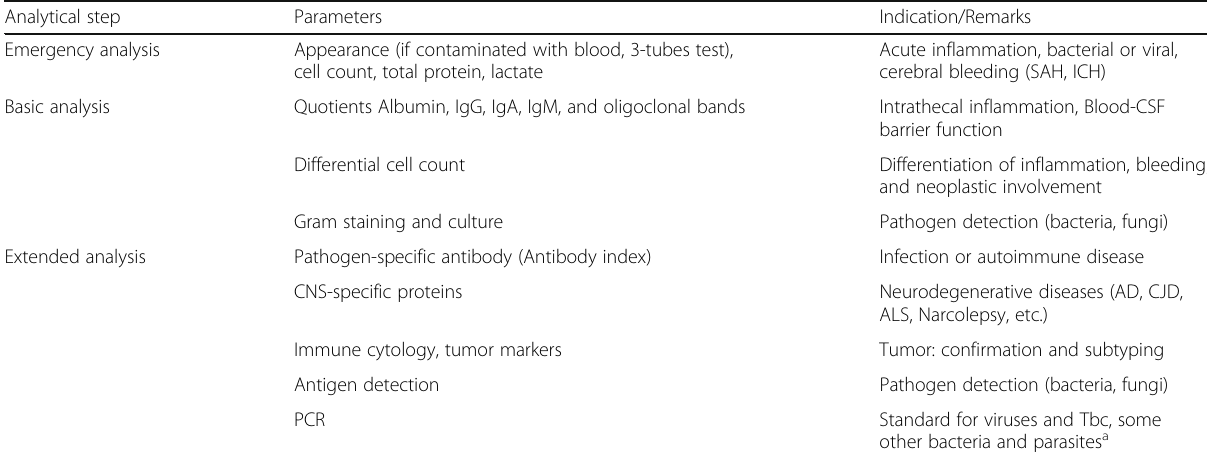
Table 3 Steps of CSF analysis Analytical step